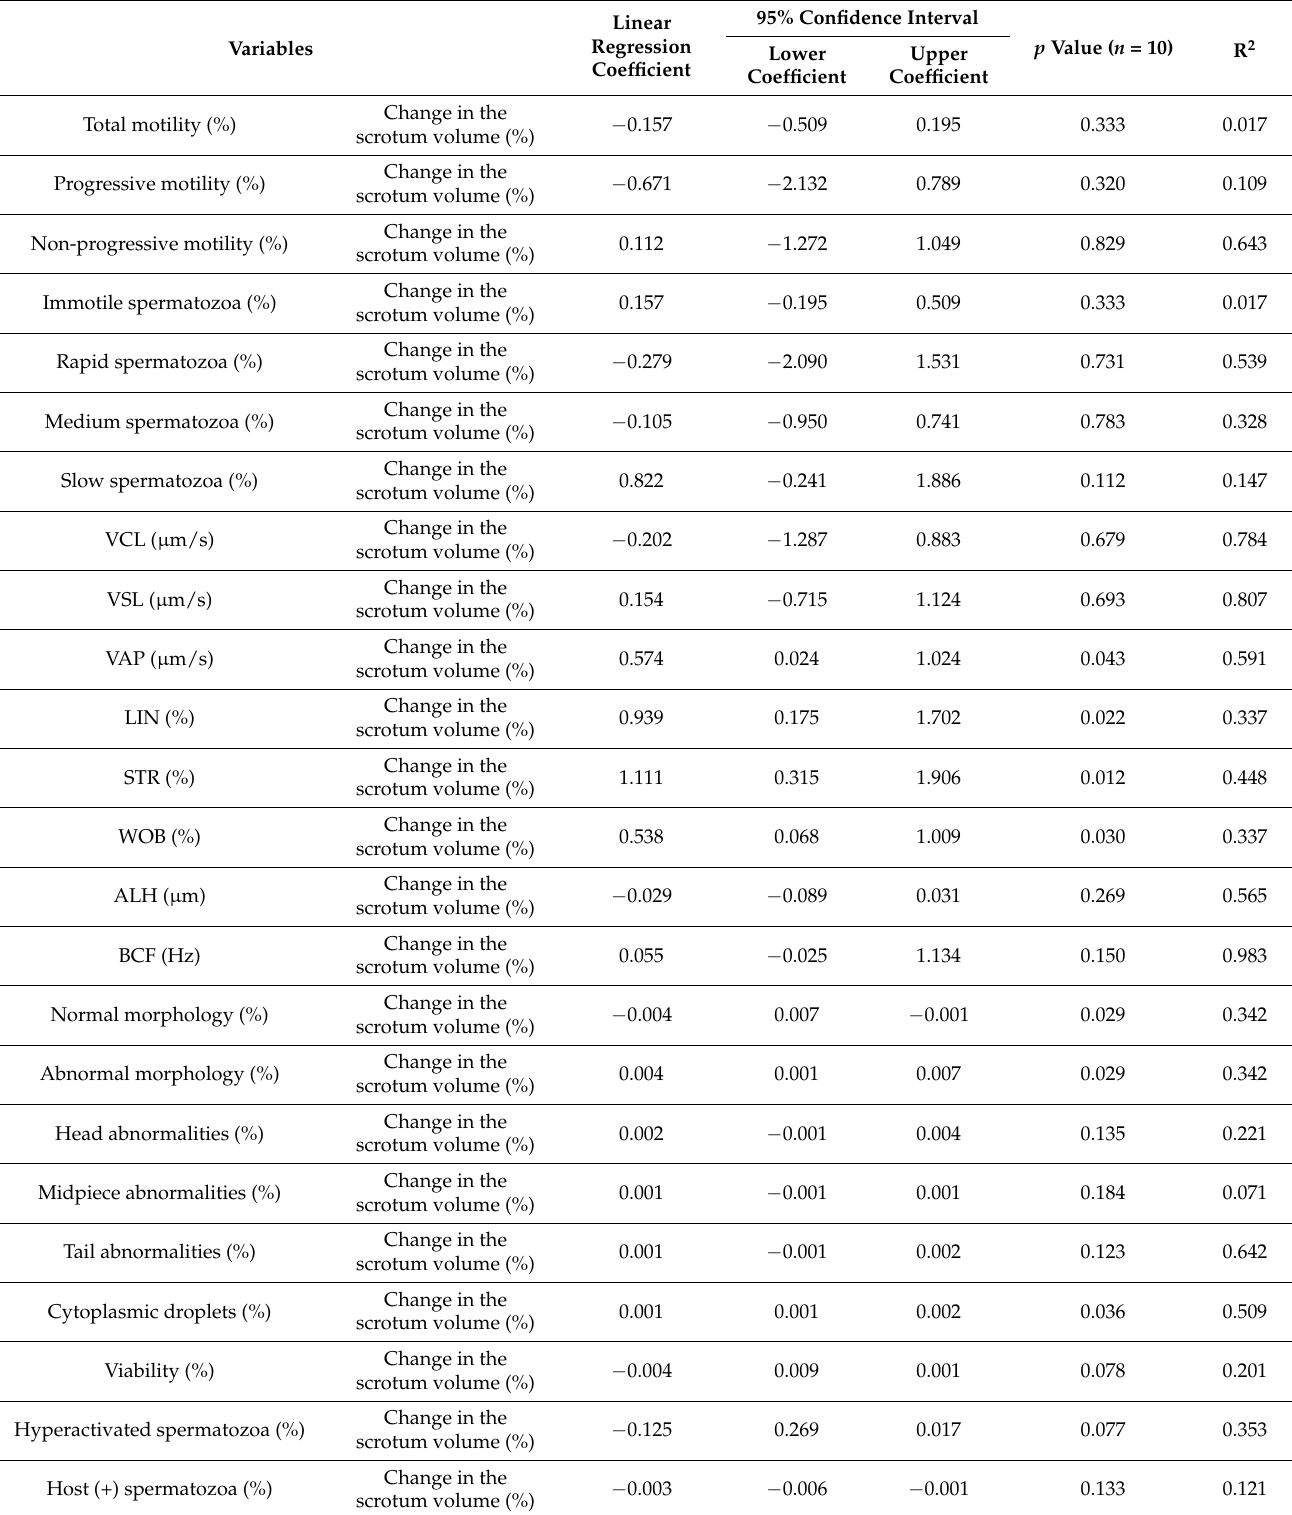
Table 1. Correlations between sperm variables, scrotal volume and duration of the